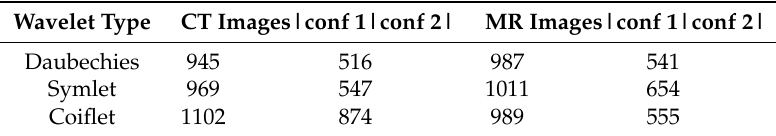
Table 5. A comparison of time consumption (calculated in seconds) for Gaussian noise for CT and MR images and individual Wavelet